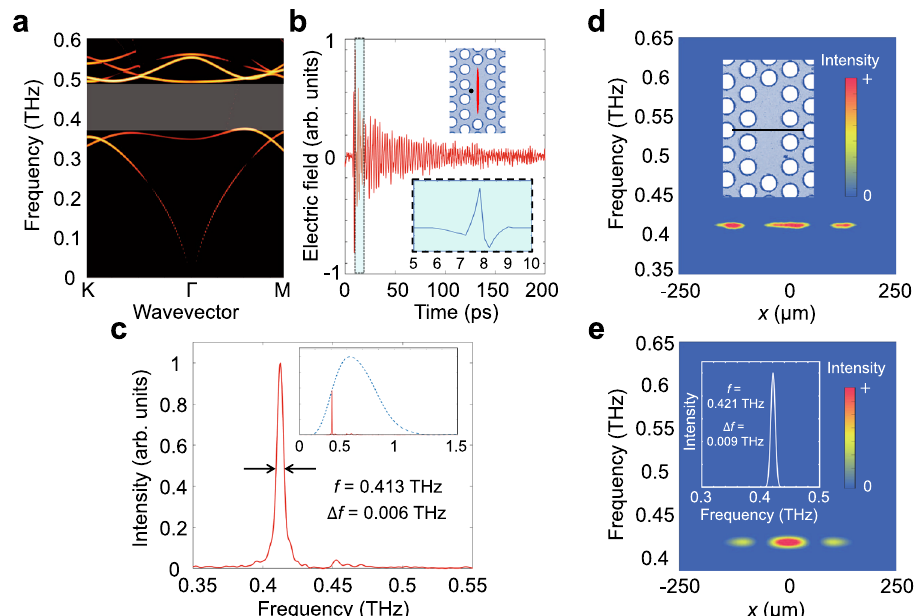
Fig. 4 Experimental phonon polaritons and simulated electromagnetic waves in the microcavity. a Energy bands of the LiNbO 3 photonic crystal. The gray region indicates the bandgap spanning from 0.375 to 0.490 THz in the band structure. b Electric fi eld oscillation of a point in the microcavity, and the point is presented by the black dot in the top inset. The top inset also shows the pump position, while the bottom inset indicates the femtosecond laser- generated broadband THz phonon polaritons, the initial oscillation after the fi rst 5 ps from the microcavity con fi ned phonon polaritons. c Spectral information of the microcavity con fi ned phonon polaritons, Fourier transformation of ( b ). The inset presents the spectral comparison between the broadband and localized phonon polaritons. d Simulated spectral information at the line shown by the inset, in the microcavity. e Spectral information along a line and at a point in the microcavity, where the positions of the line and the point are the same as in the